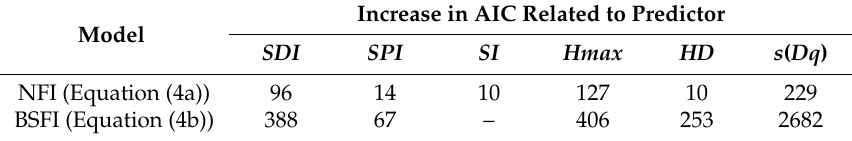
Table 5. Coefficients of the regeneration biomass model based on the BSFI (Bavarian State Forest inventory, Equations (4b) and (6)). Site Index ( SI ) was not significant as a predictor and removed from Equation (4b) (see Section 2.4); the variables are denoted as in Equations (4b) and (6), i.e., SDI (Stand Density Index), SPI (Species Profile Index), Hmax (maximum height), HD (Height Diameter Characteristic), Dq (Quadratic Mean Diameter); β 1 to β 5 are corresponding fixed effect coefficients; s ( Dq ) is a univariate penalized cubic regression spline [31] over Dq (Figure 2a); b i is the random effect specific for the forest management unit, and s 3 is its standard deviation; b ij is the stand specific random effect, and s 4 is its standard deviation; ε ij represents the i.i.d errors and s 5 represents their standard deviations. Fixed Effect of Random Effect Intercept SDI SPI SI Hmax HD s ( Dq ) b i b ij ε ijk Symbol 1 β 0 β 1 β 2 – β 4 β 5 – Value 40,074 − 4.59 − 1194 – 255 − 4610 1150 7684 SE 251 0.48 289 – 26 571 – p -value <0.0001 <0.0001 <0.0001 – <0.0001 <0.0001 <0.0001 1 In Equation (4b). Table 6. The increase of the AIC related to each predictor when it was removed as the only one from Equation (4a) and the nested model of Equation (4b) with minimum AIC (see Section 2.4). Abbreviations are NFI (German National Forest Inventory) and BSFI (Bavarian State Forest Inventory). Increase in AIC Related to Predictor Model SDI SPI SI Hmax HD s ( Dq ) NFI (Equation (4a)) 96 BSFI (Equation (4b))